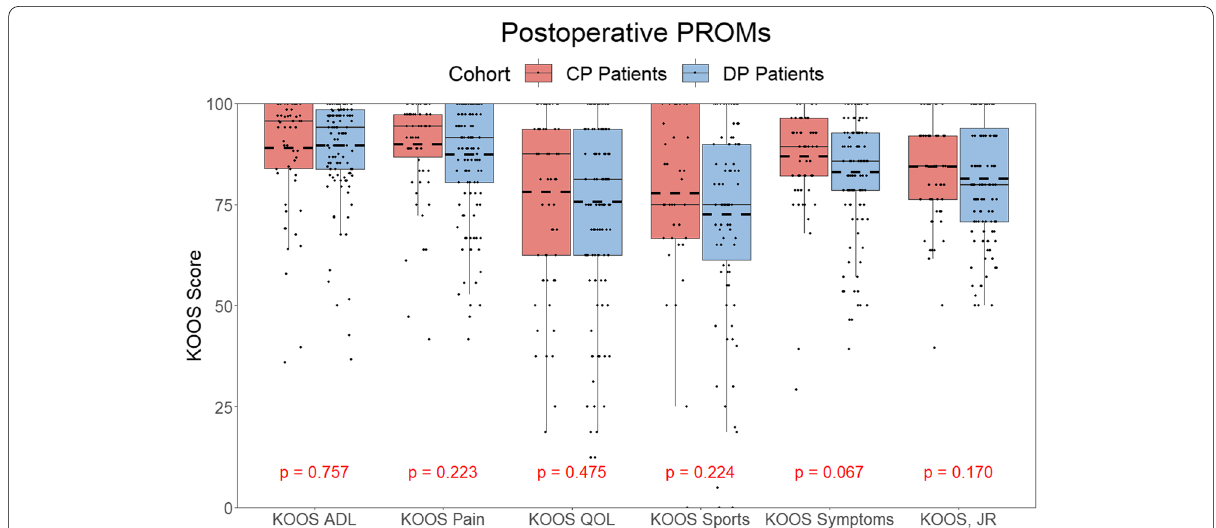
Fig. 3 Box and Whisker Plot of the postoperative KOOS results taken after 12 months from surgery had elapsed. No statistically significant differences were observed between the DP Patients and CP Patients for any postoperative